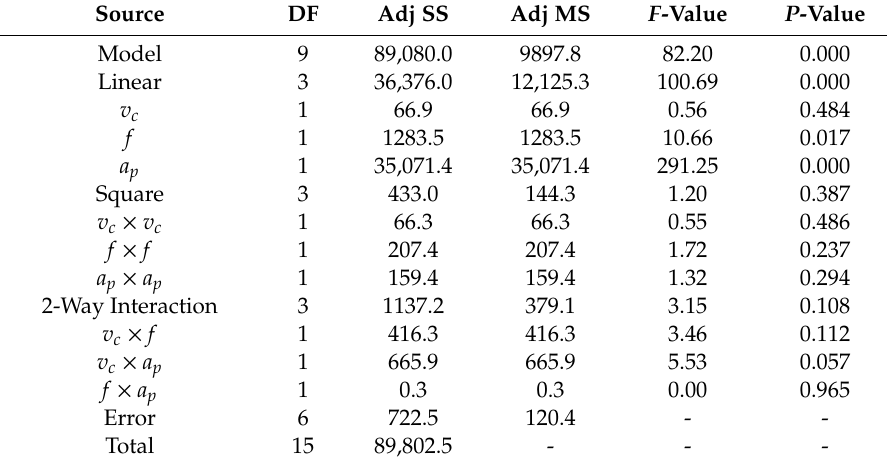
Table 5. Analysis of variance of response surface regression: F z versus v c , f , a p . Source DF Adj SS Adj MS F -Value P